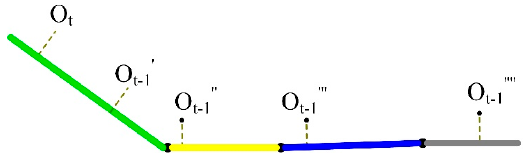
Figure 3. State transit based on the network connectivity.